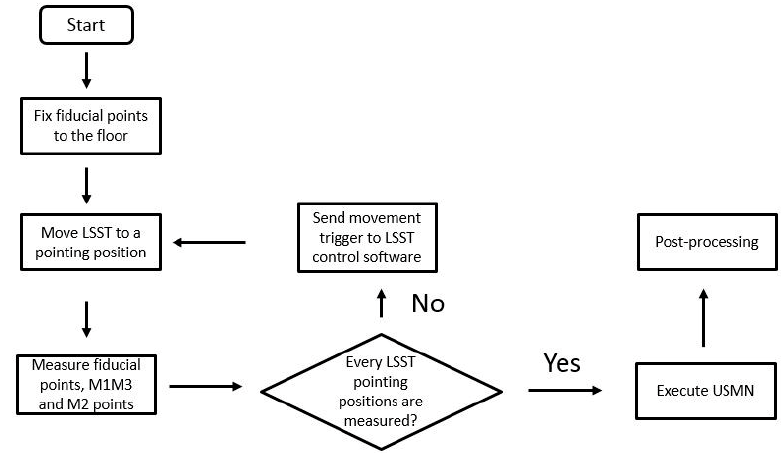
Figure 9. Fully automatic RPE verification procedure flow chart.